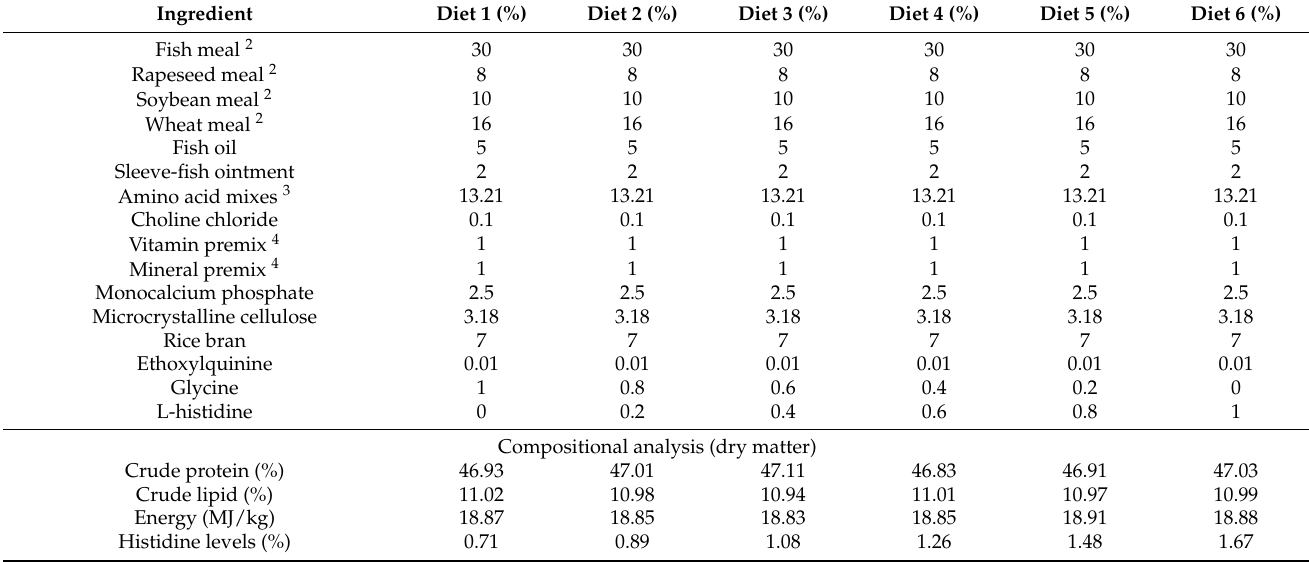
Table 1. Ingredients and proximate compositions of experimental diets (% dry matter) 1